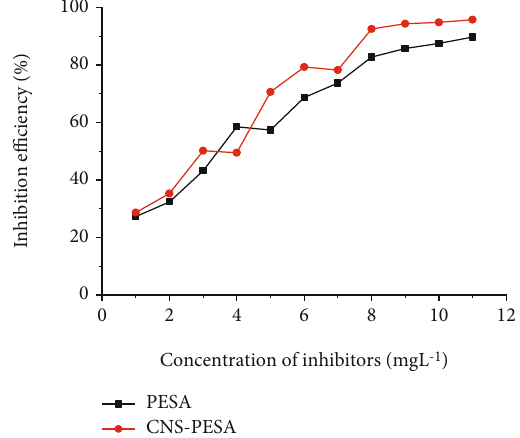
Figure 4: Calcium carbonate scale inhibition e ffi ciency of PESA and CNS-PESA.